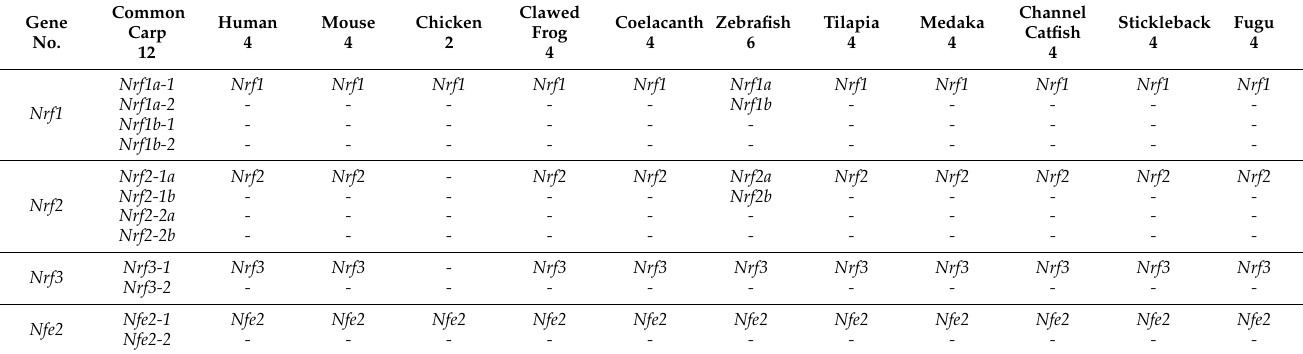
Table 4. Comparative analysis of Nrf genes from common carp with other